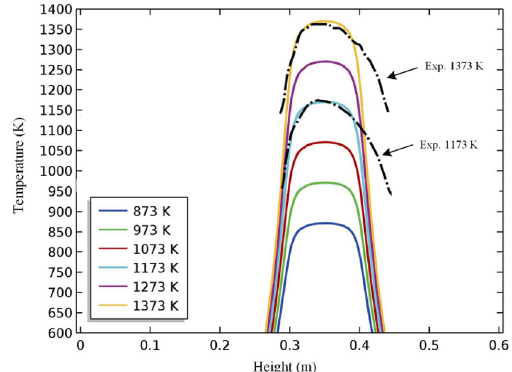
Fig. 3 Axial temperature distribution curve in the reactor at different deposition temperatures.